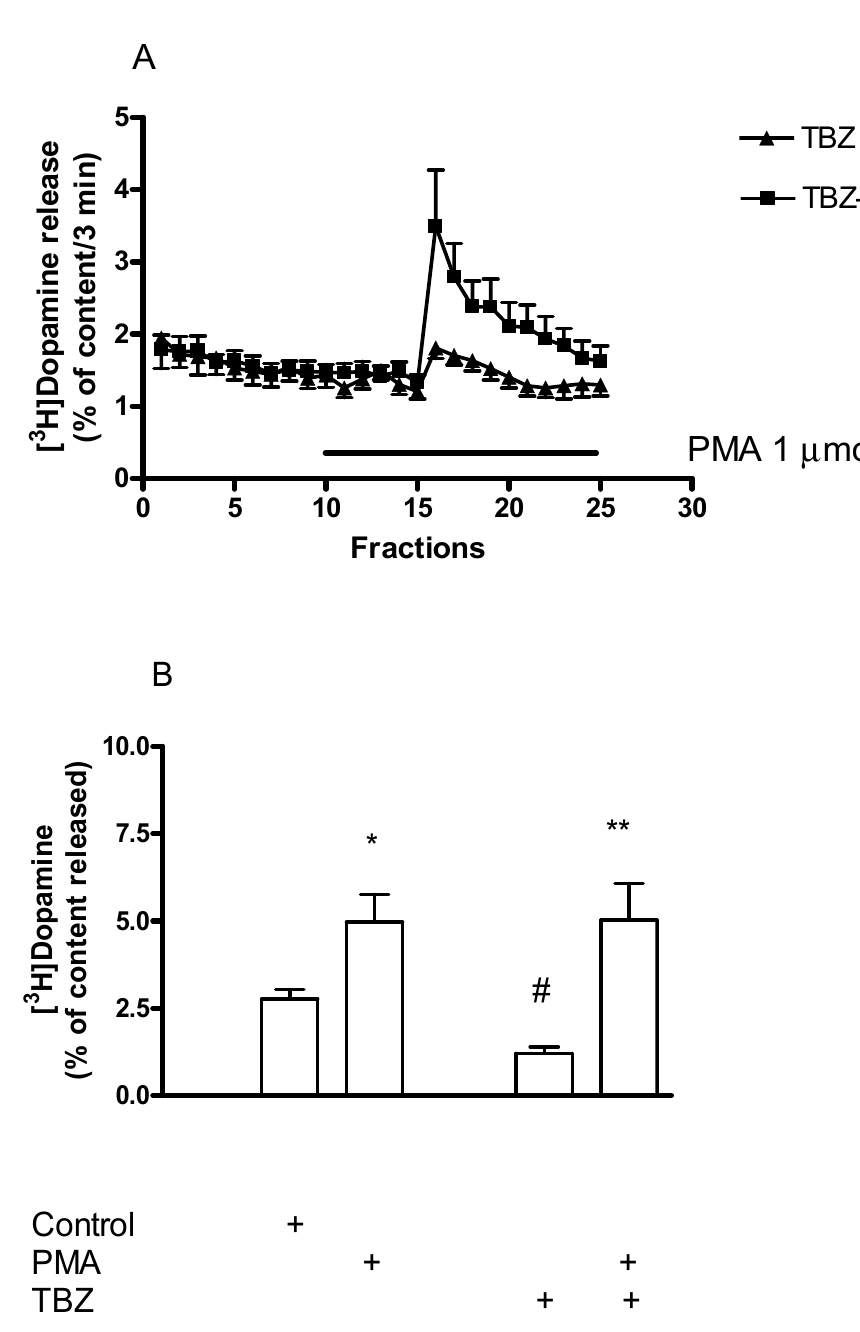
Figure 21. Phorbol 12-myristate 13-acetate (PMA) reversed the inhibitory effect of tetrabenazine (TBZ) on [ 3 H]dopamine release in rat striatum. Striatal slices were prepared from non-treated and TBZ-pretreated (1 mg/kg sc 60 min before the experiment) rats, loaded with [ 3 H]dopamine and superfused. The resting and the electrical stimulation (40 V, 10 Hz, 2-msec for 3 min in fraction 16)-induced [ 3 H]dopamine release was determined as a fractional rate. ( A ) PMA was added from fraction 10 in a concentration of 1 µ mol/L to striatal slices obtained from TBZ-pretreated rats and was maintained throughout the experiment. ( B ) TBZ pretreatment decreased the electrical stimulation-induced [ 3 H]dopamine release from striatum: the release was 2.78 ± 0.19 in control and 1.21 ± 0.19 percent of content in tetrabenazine-pretreated rat striatum, # p < 0.05. PMA (1 µ mol/L) increased the electrical stimulation-induced [ 3 H]dopamine release in non-treated and TBZ-pretreated rat striatum by 178 and 475%, respectively. Student t -statistics for two-means, * p < 0.05, ** p < 0.01, mean ± S.E.M., n = 6-8.